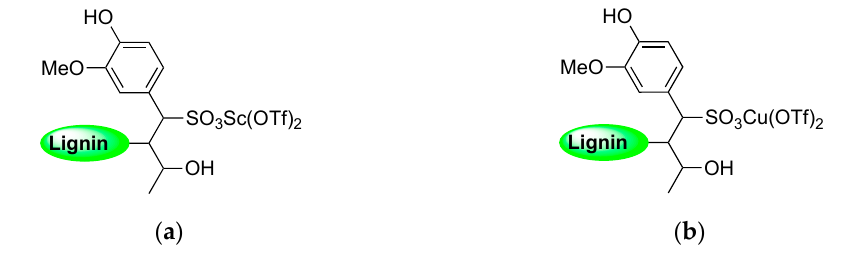
Figure 3. Proposed chemical structures for ( a ) LSA-Sc 3+ and ( b ) LSA-Cu 2+ catalysts. Adapted with permission from reference [33]. Copyright 2014 Atlanta Publishing House